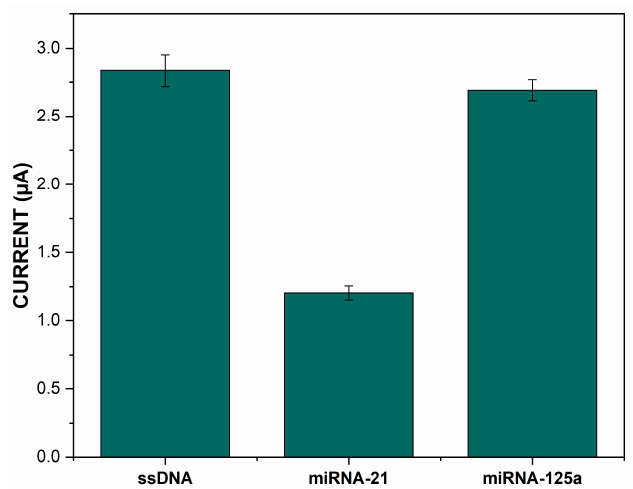
Figure 8. Differential pulse voltammetry reduction current of MB on BSA/ssDNA-CysAm/AuNPs/CB/PGE before and after hybridization with complementary (microRNA-21) (RSD% = 2.75%) and non-complementary (microRNA-125a) sequences (RSD% = 2.81%). Incubation in 20 µM MB at Tris-HCl buffer (20 mM, pH 7.00) including 20 mM NaCl for 5 min and washing with the same buffer including 20 mM NaCl (n = 3).